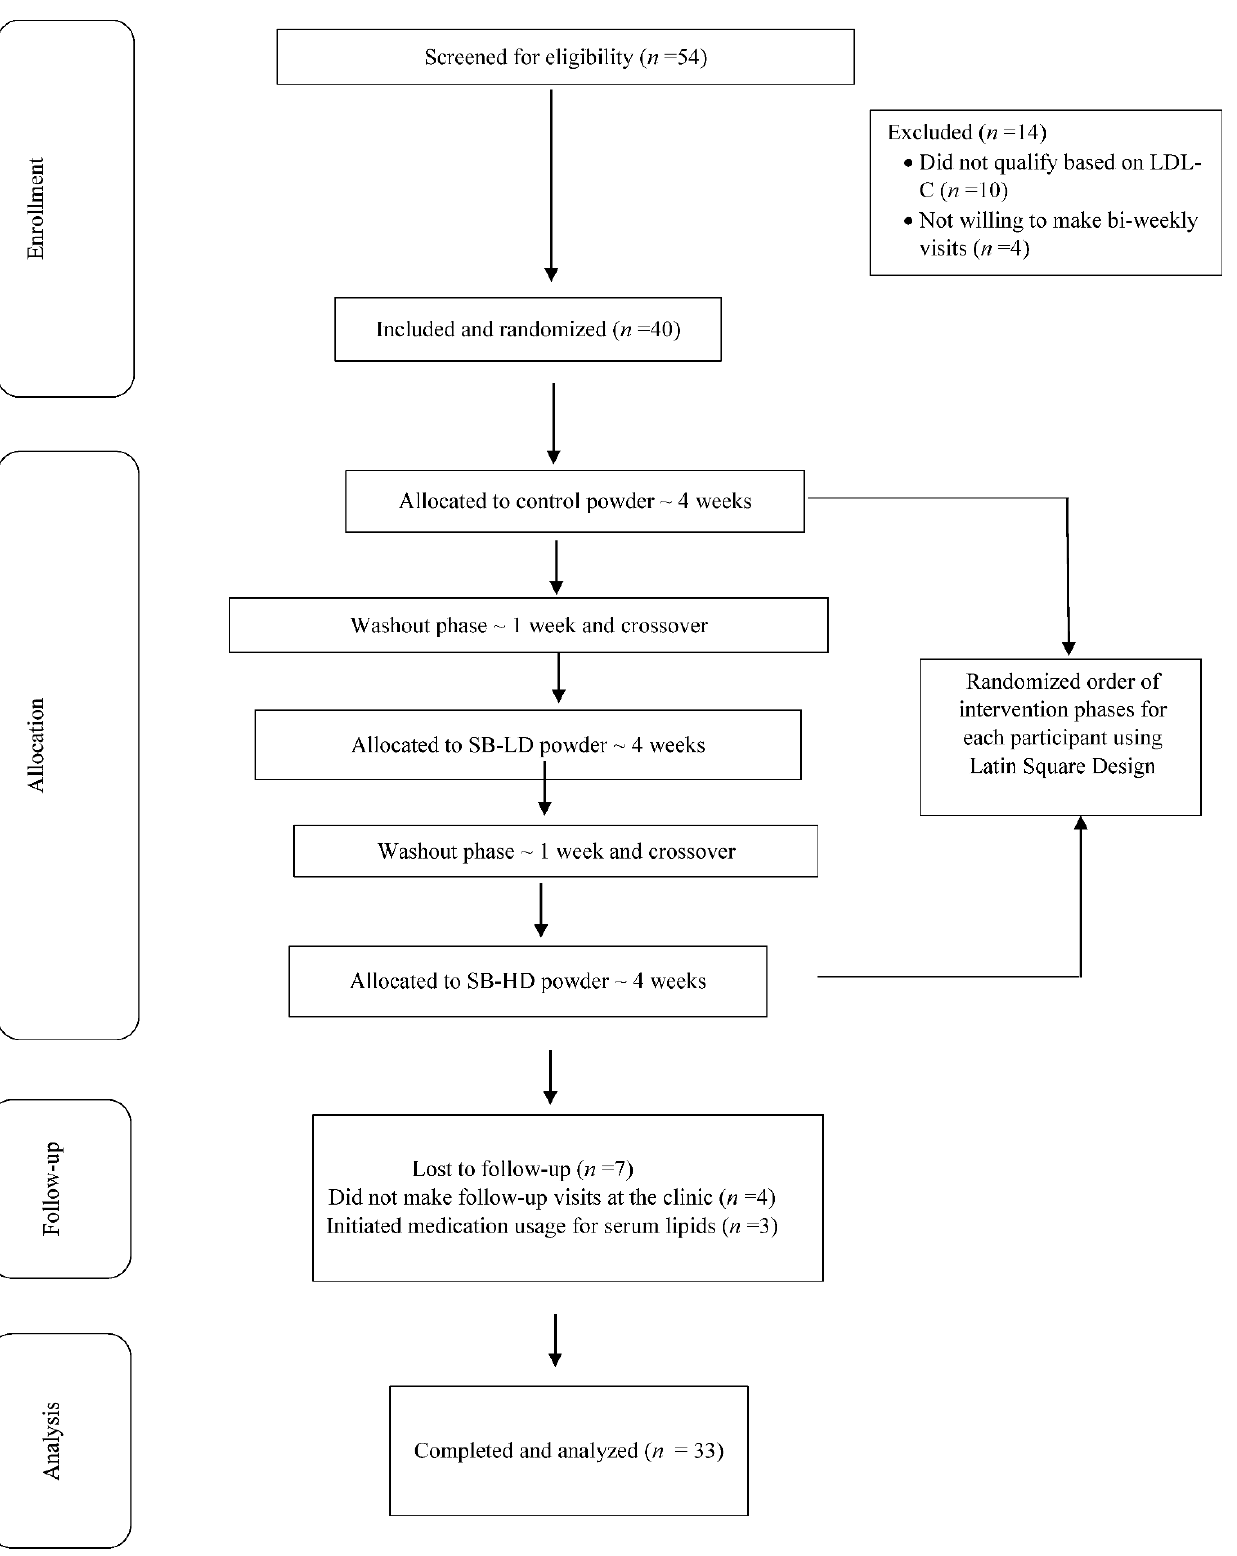
Figure 1. Study design. LDL-C: LDL cholesterol; SB–LD: low-dose strawberry phase; SB–HD: high-dose strawberry